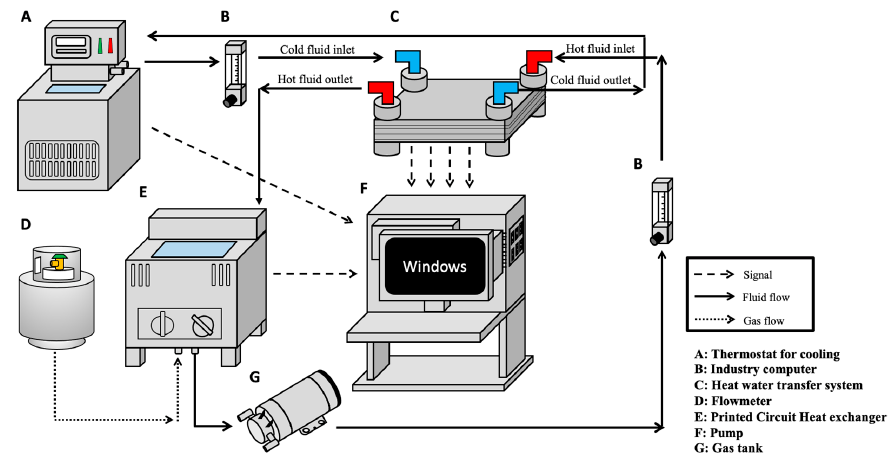
Figure 3. Schematic diagram of the experiment setup.